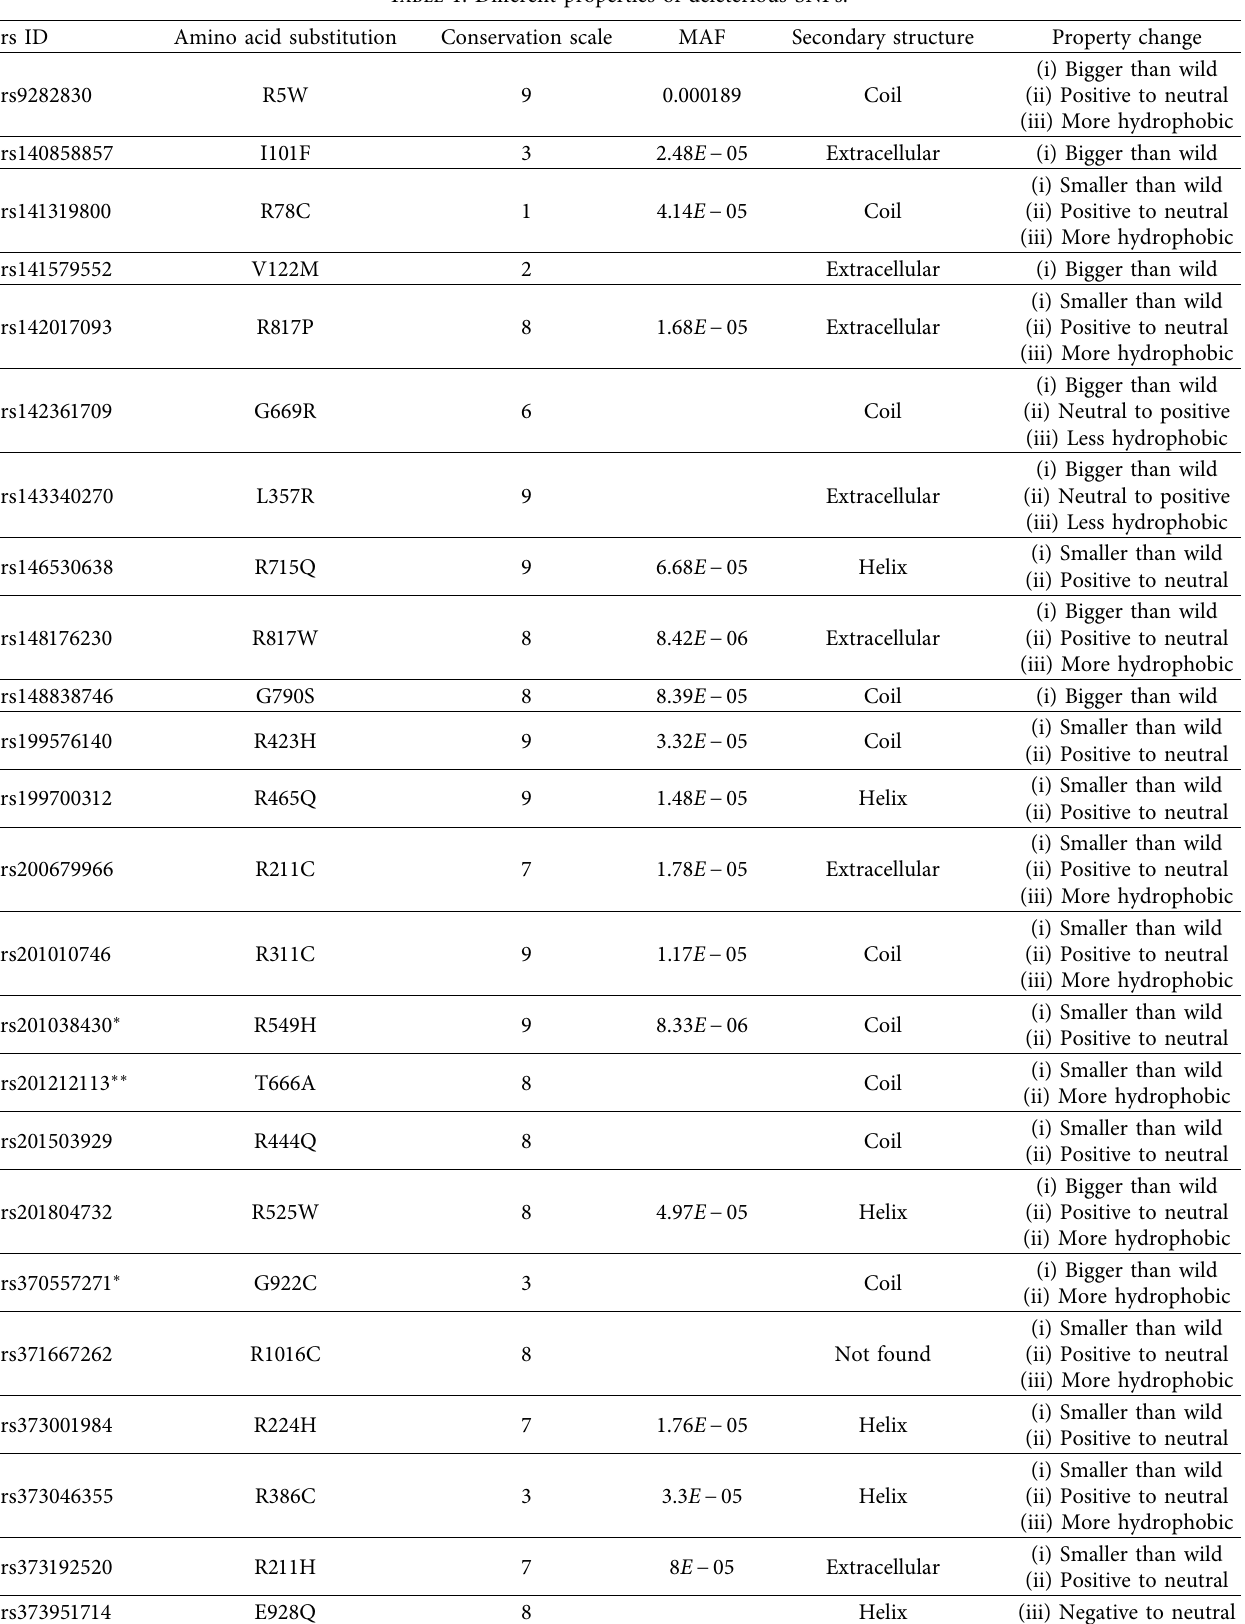
Table 1: Different properties of deleterious